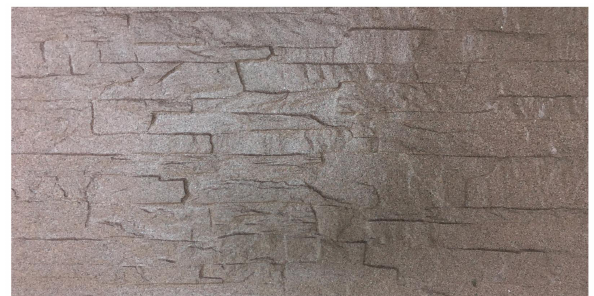
Figure A2. The photo of artificial rock (60cm length × 30cm width). Limpets were placed on artificial rock and heated to the des- ignated